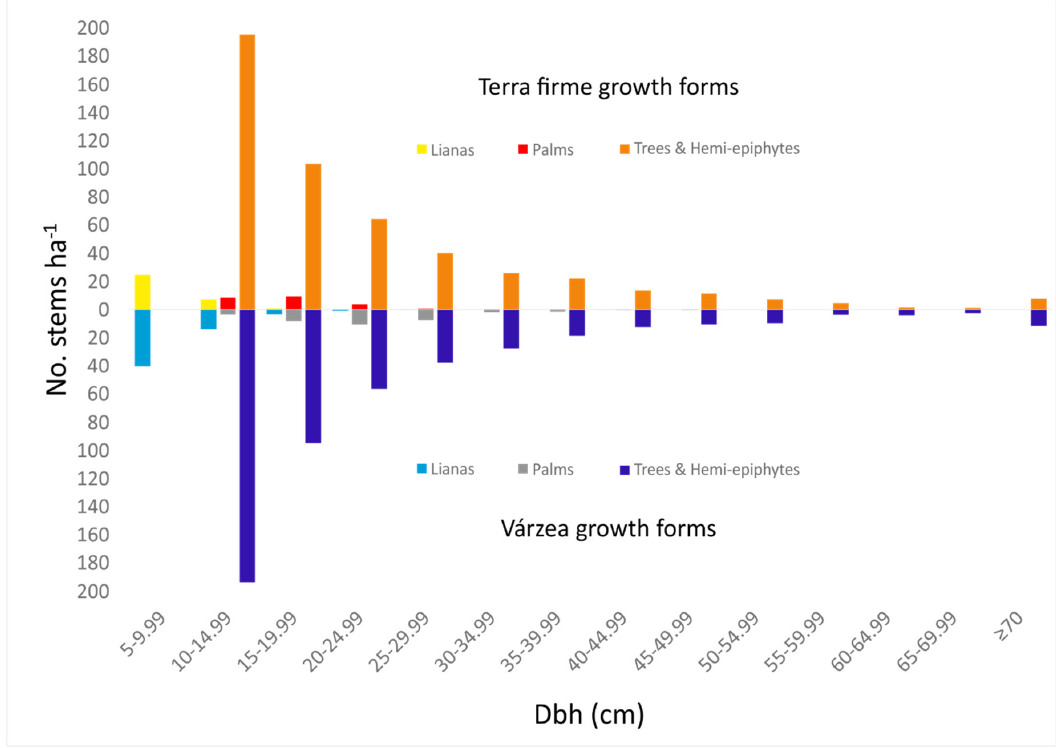
Figure 2. Number of stems per hectare across diameter at breast height (Dbh) size classes with five cm intervals where, e.g., 5–9.99 is from five cm dbh up to, but not including, 10 cm dbh. Values are given per growth form for terra firme (yellow = lianas, red = palms, orange = trees and hemi-epiphytes) and várzea (light blue = lianas, grey = palms, dark blue = trees and hemi-epiphytes) forests along the central reaches of the Juruá River, western Brazilian Amazon.